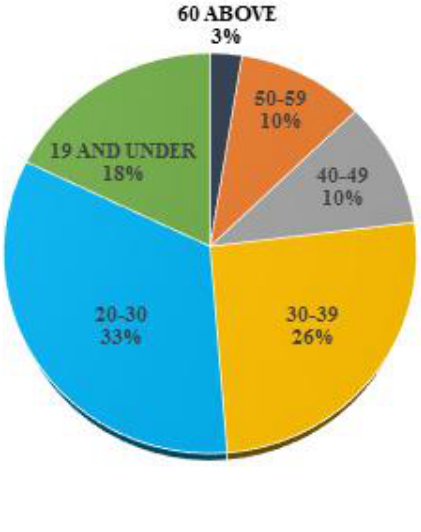
Fig. 5: Different age categorizes